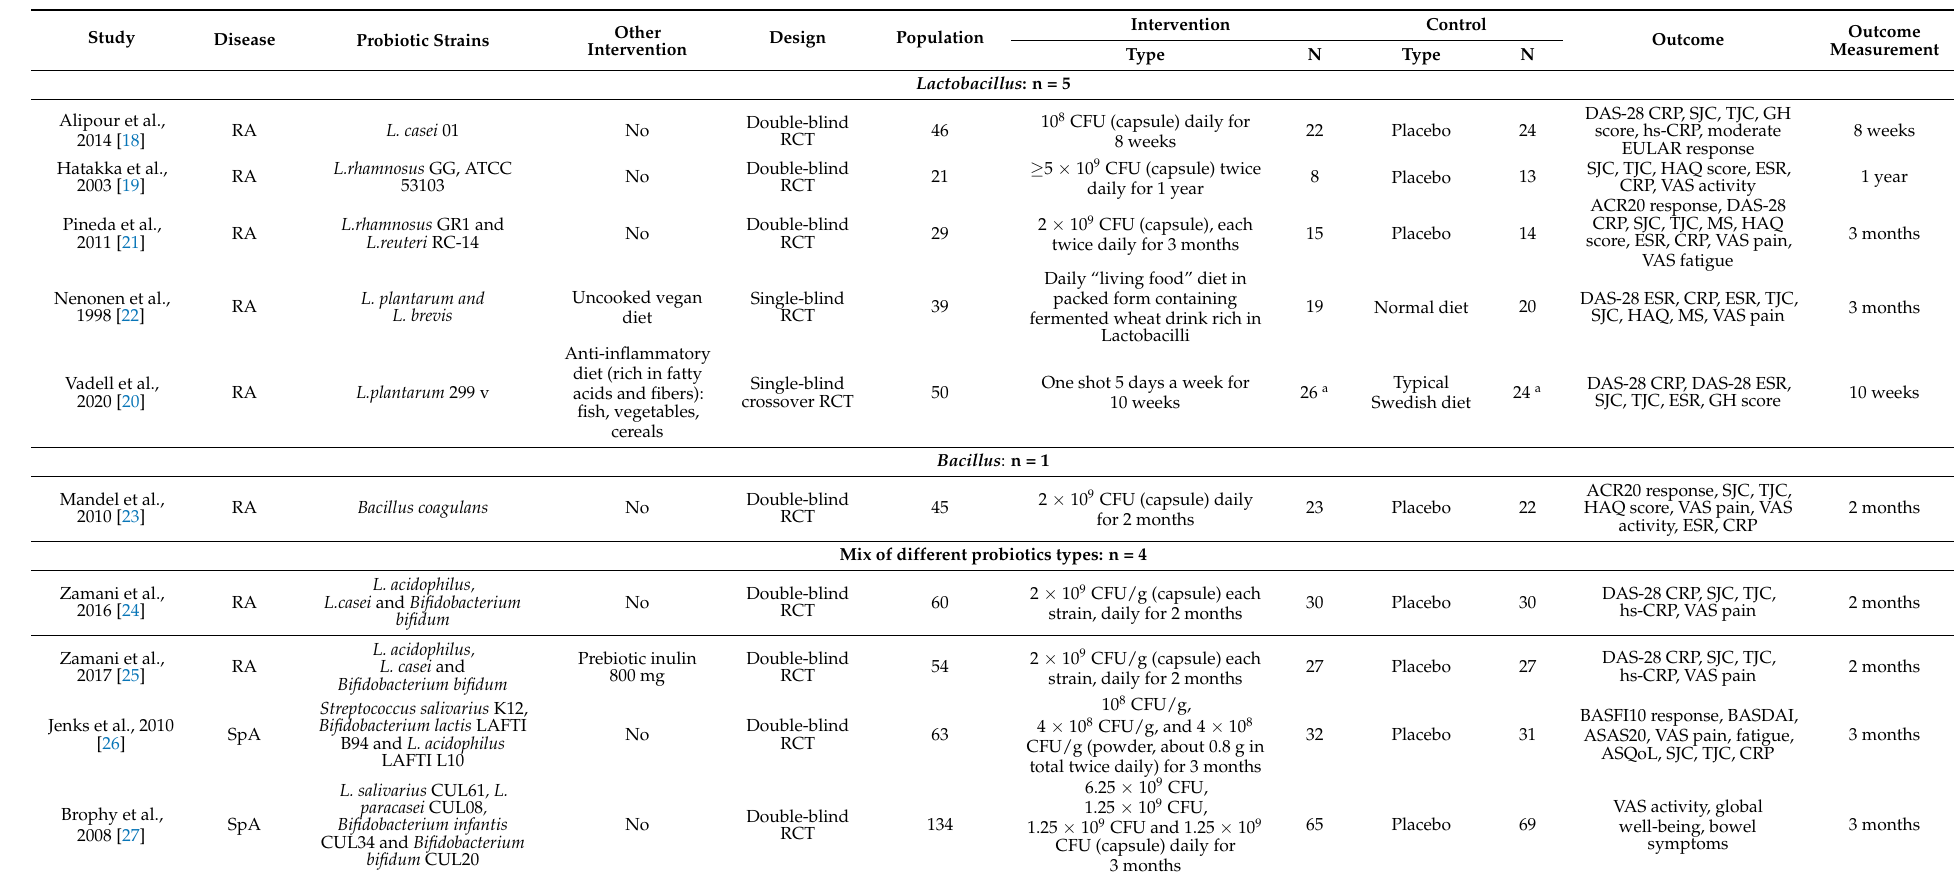
Table 2. Study characteristics of the 10 studies included in the systematic review sorted by probiotic